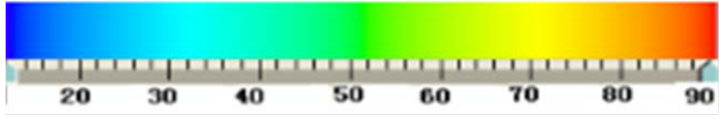
Figure 8. The relationship between oil saturation value and color .